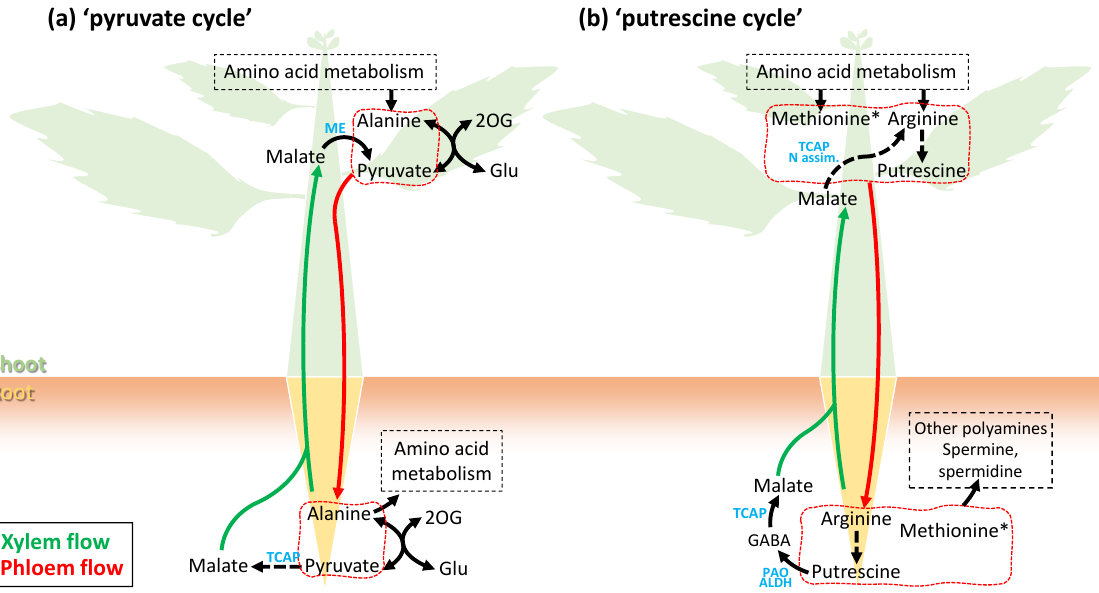
Figure 3. Two examples of possible metabolic cycles suggested by phloem sap metabolome. ( a ) Pyruvate cycle. Alanine and pyruvate are interconvertible via alanine transaminases with glutamate (Glu) and 2-oxoglutarate (2OG). They are present in phloem sap and could feed malate production in sink organs (roots) via the tricarboxylic acid pathway (TCAP), and malate can then be sent back to shoots via xylem sap. In shoots, malate can be cleaved by the malic enzyme (ME) to produce pyruvate. ( b ) Putrescine cycle. Arginine, methionine and putrescine synthesized in shoots can be used to feed higher degree polyamine synthesis (spermine, spermidine) in roots, and putrescine can be oxidized to 4-aminobutyrate (GABA) via polyamine oxidase (PAO) and aldehyde dehydrogenase (ALDH) and then to malate via the TCAP. As in ( a ), malate can be exported back to shoots to feed organic acid synthesis, and thus glutamate and aspartate production via N assimilation, sustaining arginine synthesis. The asterisk stands for the contribution of methionine derivatives: SMM and